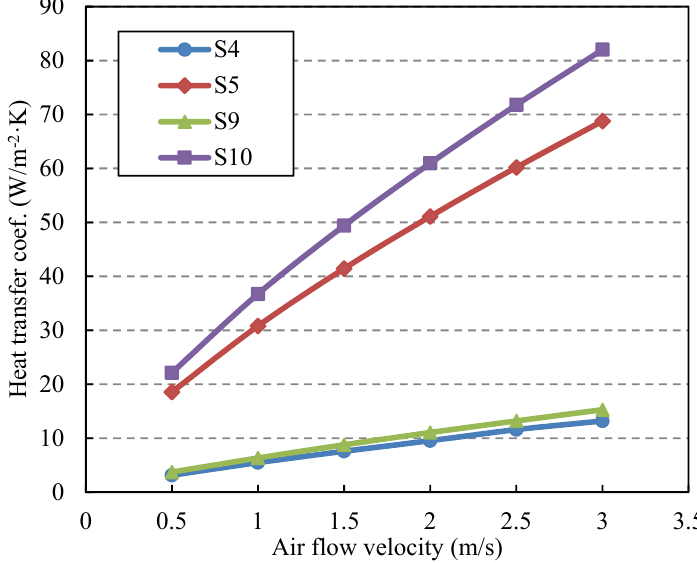
Figure 22. The convection heat transfer coefficients vs. air flow